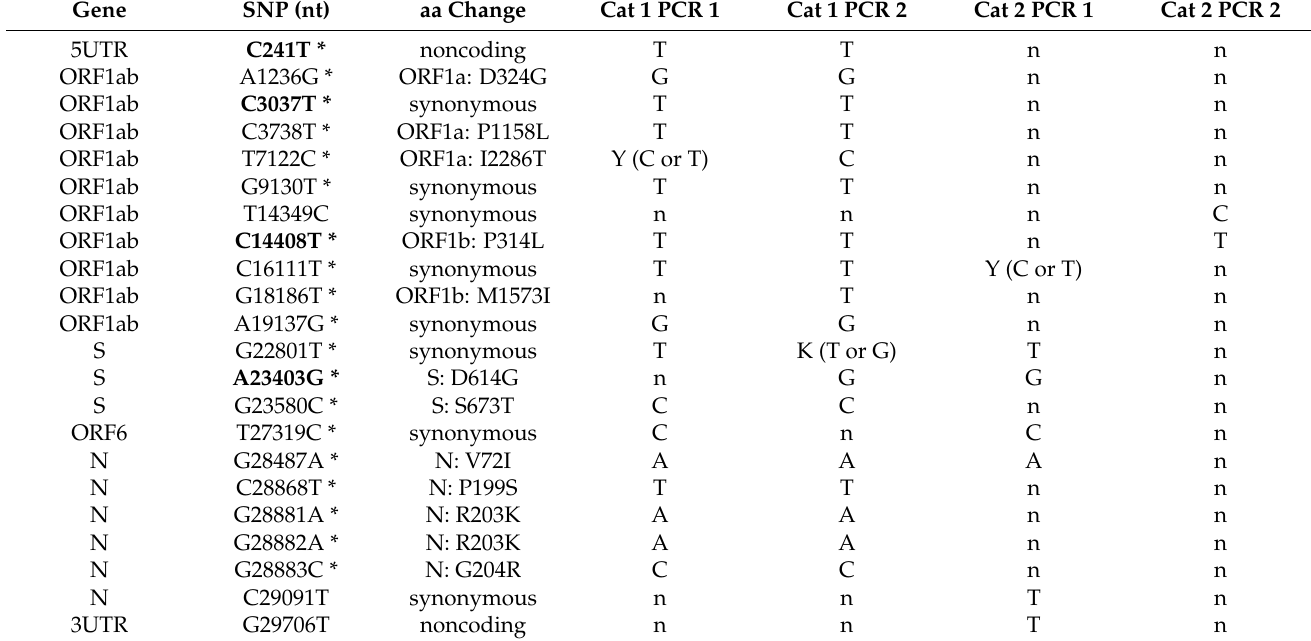
Table 2. Single nucleotide polymorphisms (SNPs) that are present in at least one of the four sequences. SNPs that were inconsistent between sequences from the same cat are not reported. Genome coordinates are with reference to sequence Wuhan-Hu-1 (MN908947). SNPs that are shared between the consensus sequence of Cat 1 and 18 other cat isolates available on GISAID on 26 January 2021 are highlighted in bold